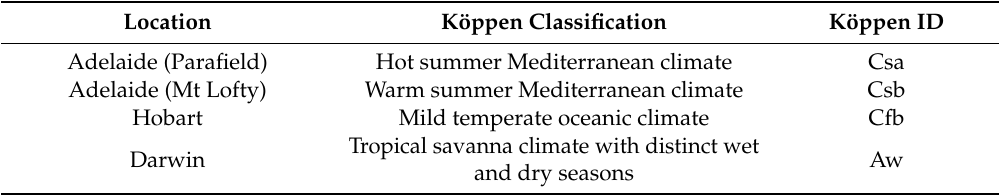
Table 3. Climate scenarios and Köppen classification.